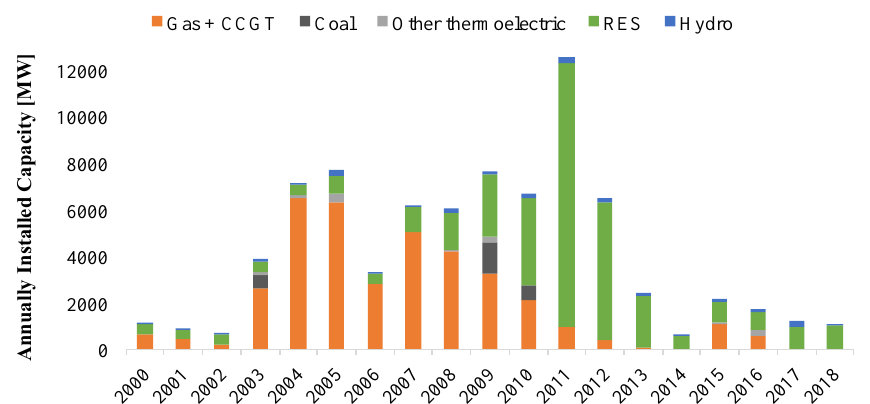
Figure 1. New thermoelectric capacity installed annually in Italy between 2000 and 2018 (author’s elaborations on Terna, Transparency Report Platform [2]). CCGT, combined cycle gas turbine; RES, renewable energy source.